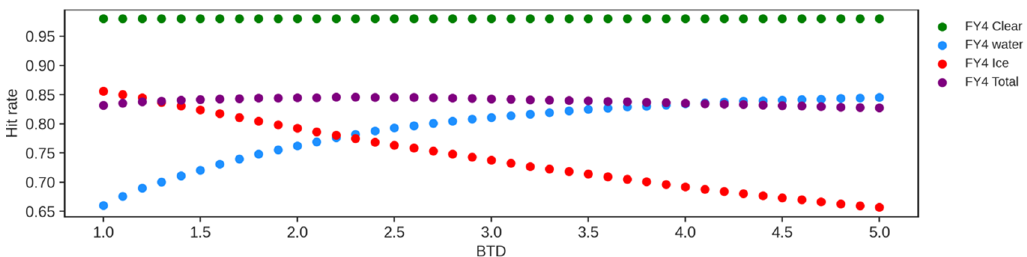
Figure 6. Sensitivity test between the FY-4A phase hit rate and BTD.